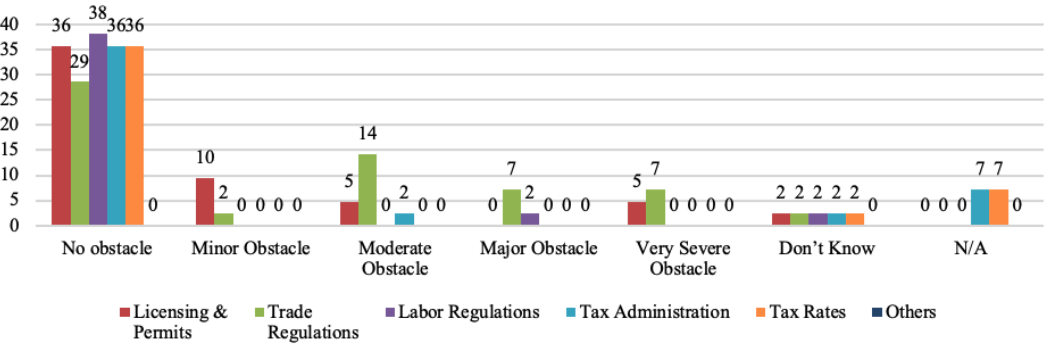
Figure 1: Elements of Policy